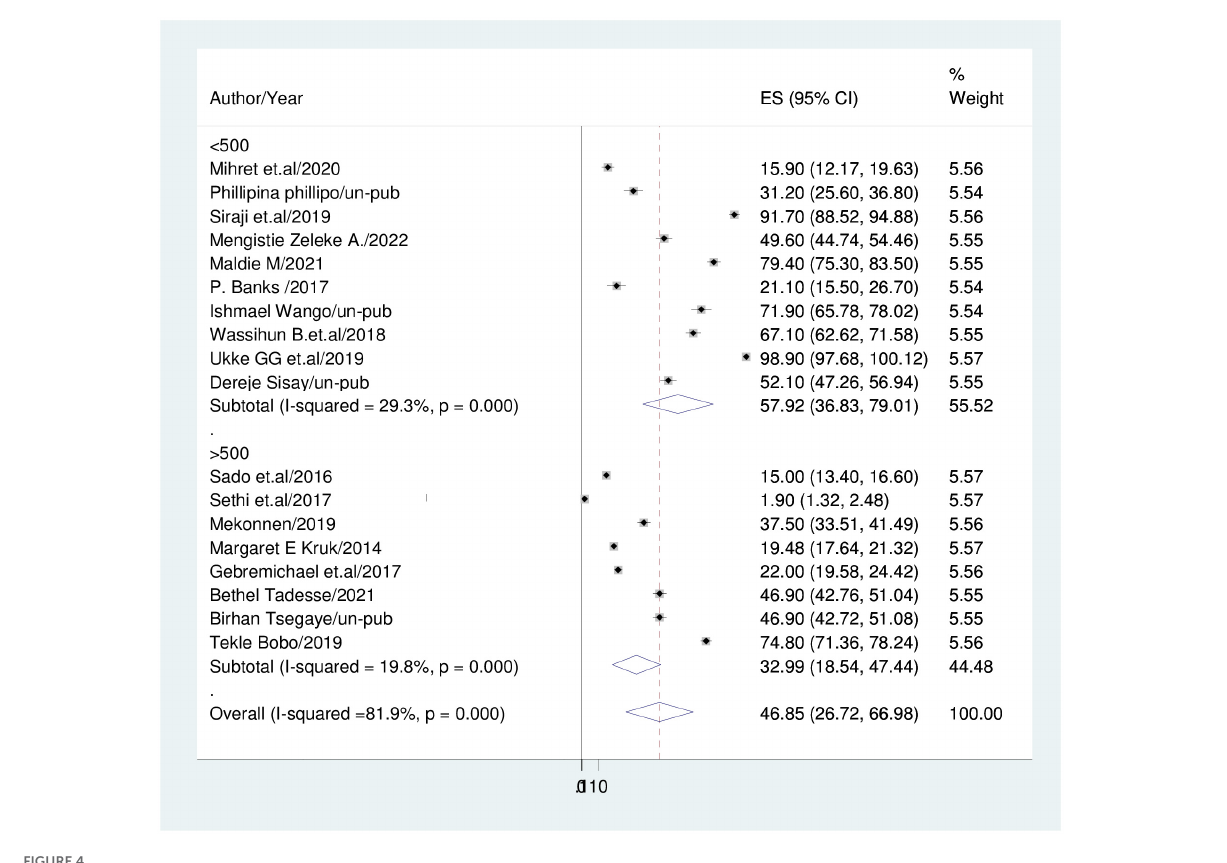
FIGURE4 Forest plot displaying subgroup-analysis based on sample size.